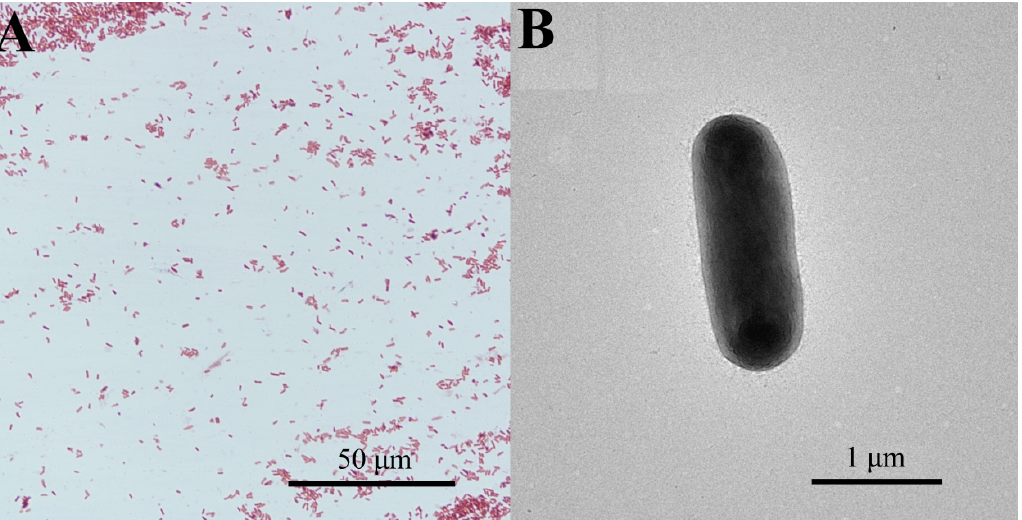
Figure 2. Morphological characteristics and TEM observation of C. freundii strain GDZQ201912. ( A ) Gram-stained strain GDZQ201912 observed by light micrograph (1000×). Scale bar 50 µm. ( B ) TEM observation of strain GDZQ201912. Scale bar 1 µm.